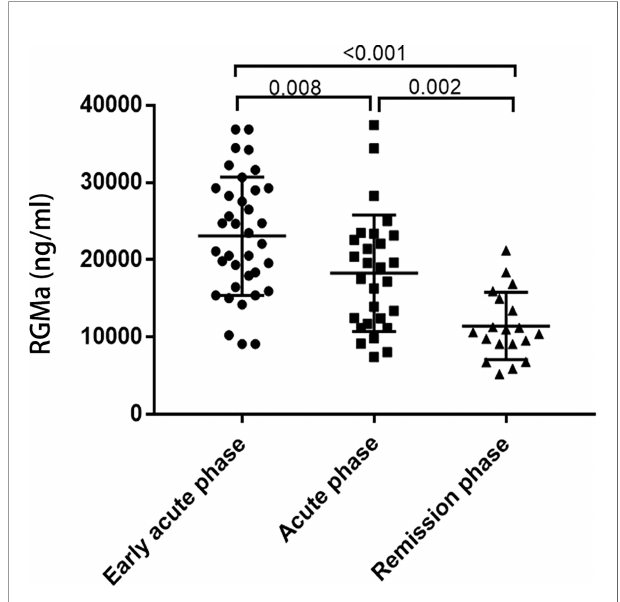
FIGURE 1 | Comparison of serum RGMa levels according to the disease